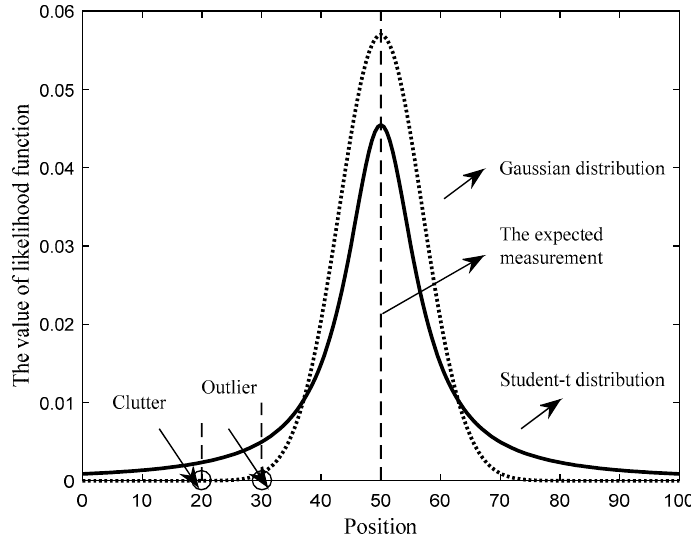
Figure 1. The illustration of measurement likelihood function.